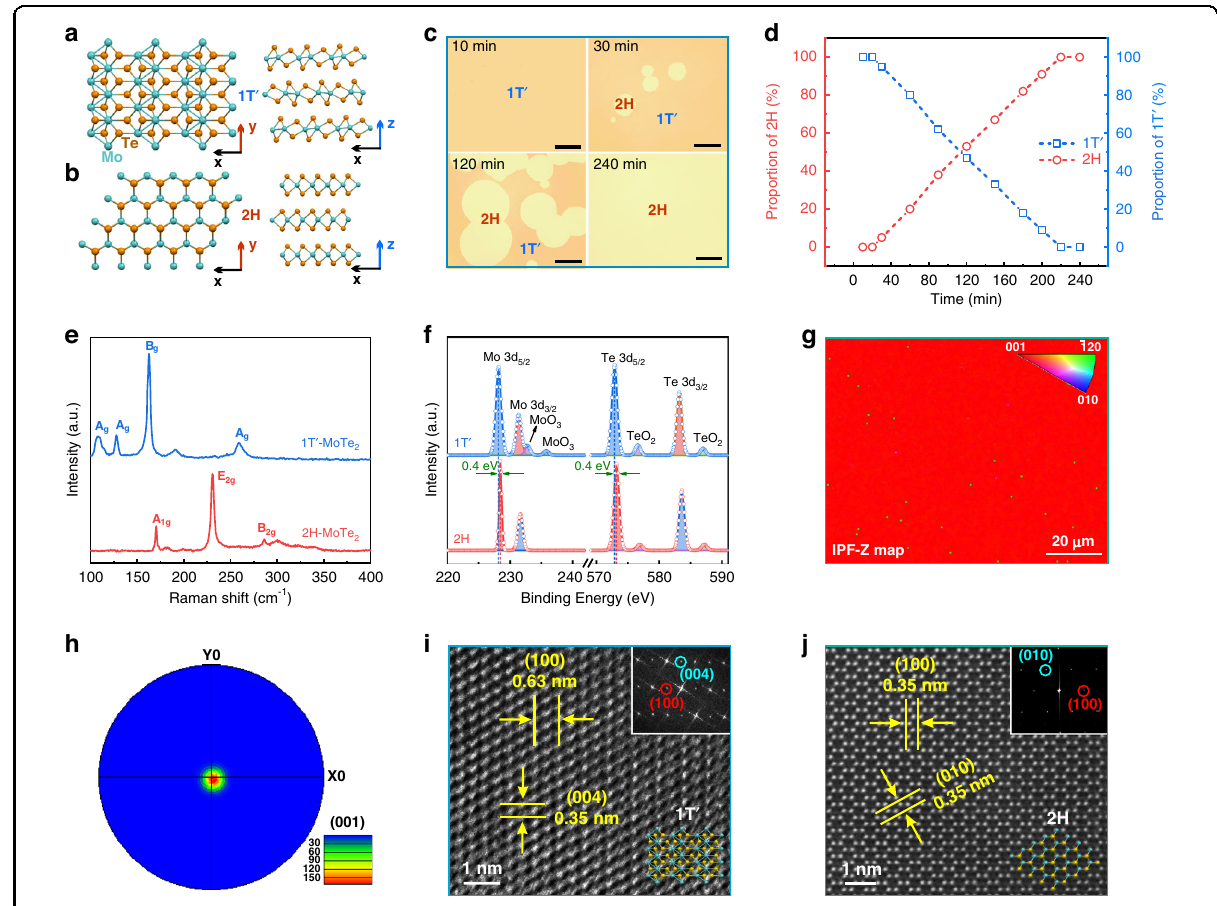
Fig. 1 Synthesis and characterization of the 2D MoTe 2 layers. a , b Atomic structures of 1 T ʹ - and 2H-MoTe 2 . c Photographs of the 2D MoTe 2 layers with different growth times. Scale bar: 100 μ m. d Proportion of 1 T ʹ - and 2H-MoTe 2 as a function of growth time. e , f Raman and XPS spectra of the 1 T ʹ - and 2H-MoTe 2 layers. g , h Inverse pole fi gures along the z -axis (IPF-Z) and pole fi gure of the 1T ʹ -MoTe 2 layers acquired from EBSD mapping on large-area. i, j Z-contrast STEM images of 1T ʹ - and 2H-MoTe 1 T ′ -MoTe further reaches 240 min, the island-like layers of 2H- redshift by ~0.4 eV compared to the semi- 2 MoTe conducting phase due to the reduction in binding energy merge together, leading to the formation of a 2 caused by Te de fi ciency 33 . Besides, the atomic ratios of uniform and continuous 2H-MoTe layer. The phase 2 transformation from 1T ′ to 2H phase can be elucidated by Te/Mo are evaluated to be ∼ 1.92 and ~1.98 for the 1T ʹ - the time-temperature-transformation (TTT) theory 32 . and 2H-MoTe layers, respectively, con fi rming the exis- 2 tence of more Te de fi ciency in the 1T ʹ -MoTe layer. As 2